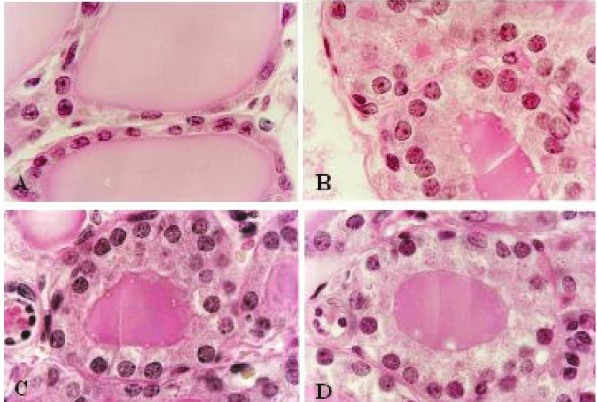
Figure 1- Photomicrograph of the central area of the right thyroid lobe of ovariectomized rats: A. the follicular epithelium is cuboidal with small nuclei (GI); B. the follicular epithelium is columnar epithelium with large nuclei (GII); C. the follicular epithelium is columnar epithelium with large nuclei (GIII); D. the follicular epithelium is columnar epithelium with large nuclei (GIV) (HE, x